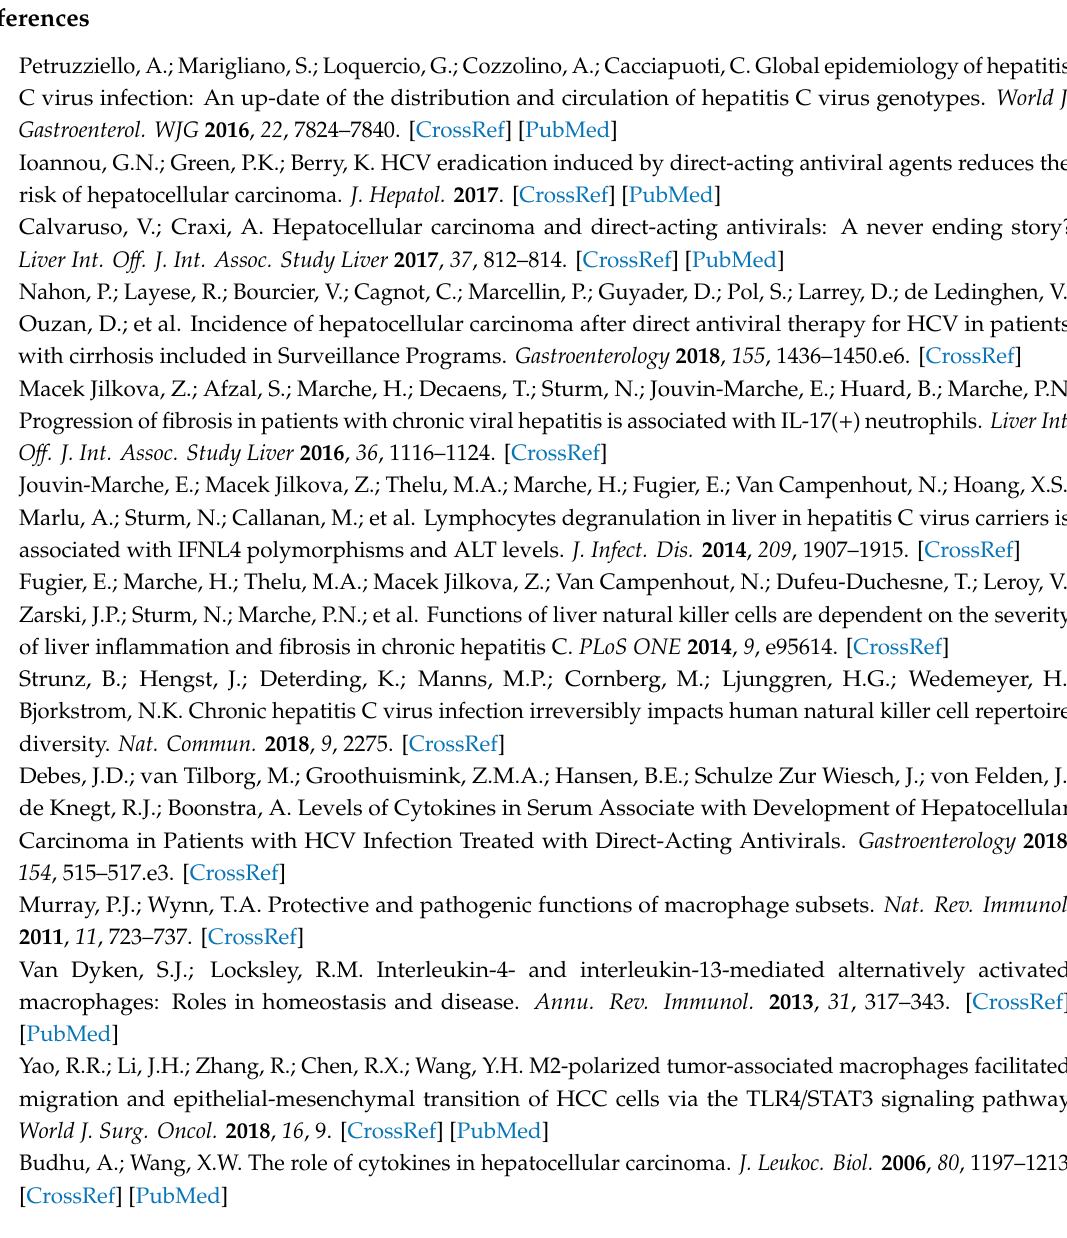
Figure S1: Serum levels of AFP and receiver operating characteristic (ROC) curve